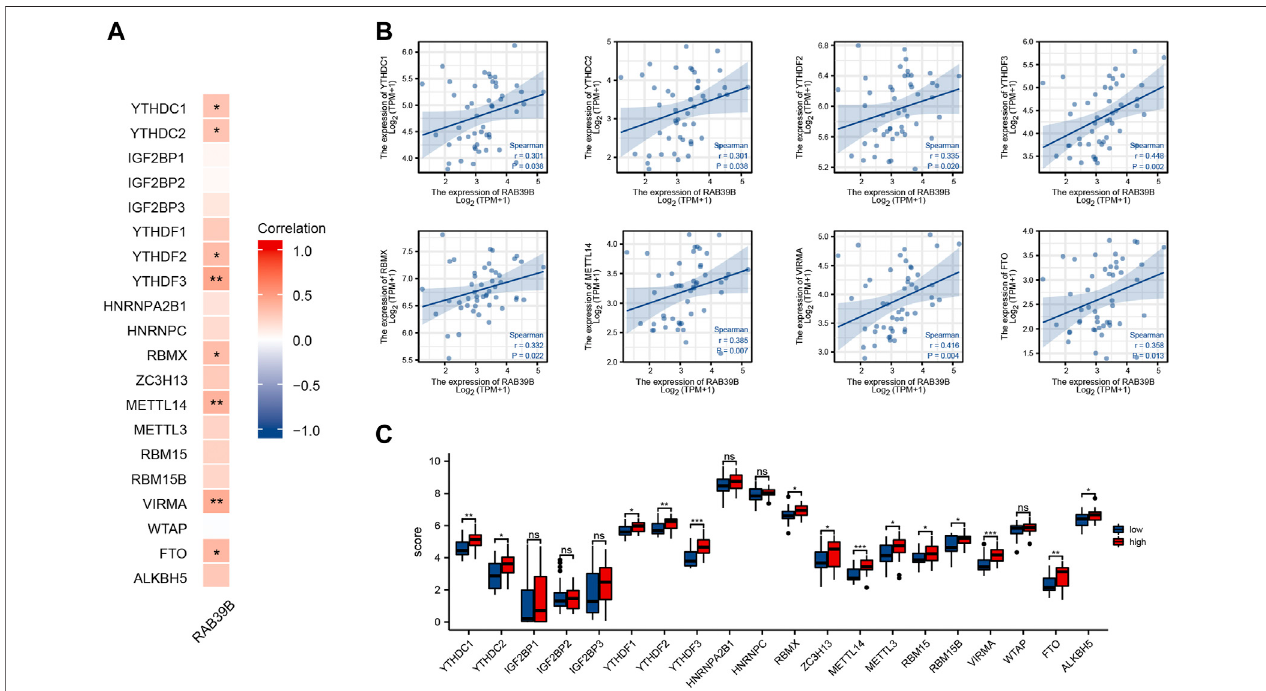
FIGURE 5 | Correlation between RAB39B and m6A-related genes in DLBCL. (A) Correlation between expression of RAB39B and m6A-related genes in TCGA DLBCLcohort. (B) ScatterplotsofthecorrelationbetweenRAB39Bandm6A-relatedgenes.m6A-relatedgenesincludeYTHDC1,YTHDC2,YTHDF2,YTHDF3,RBMX, METTL14, VIRMA, and FTO. (C) Variation among m6A-related genes in the high and low RAB39B expression groups in DLBCL.